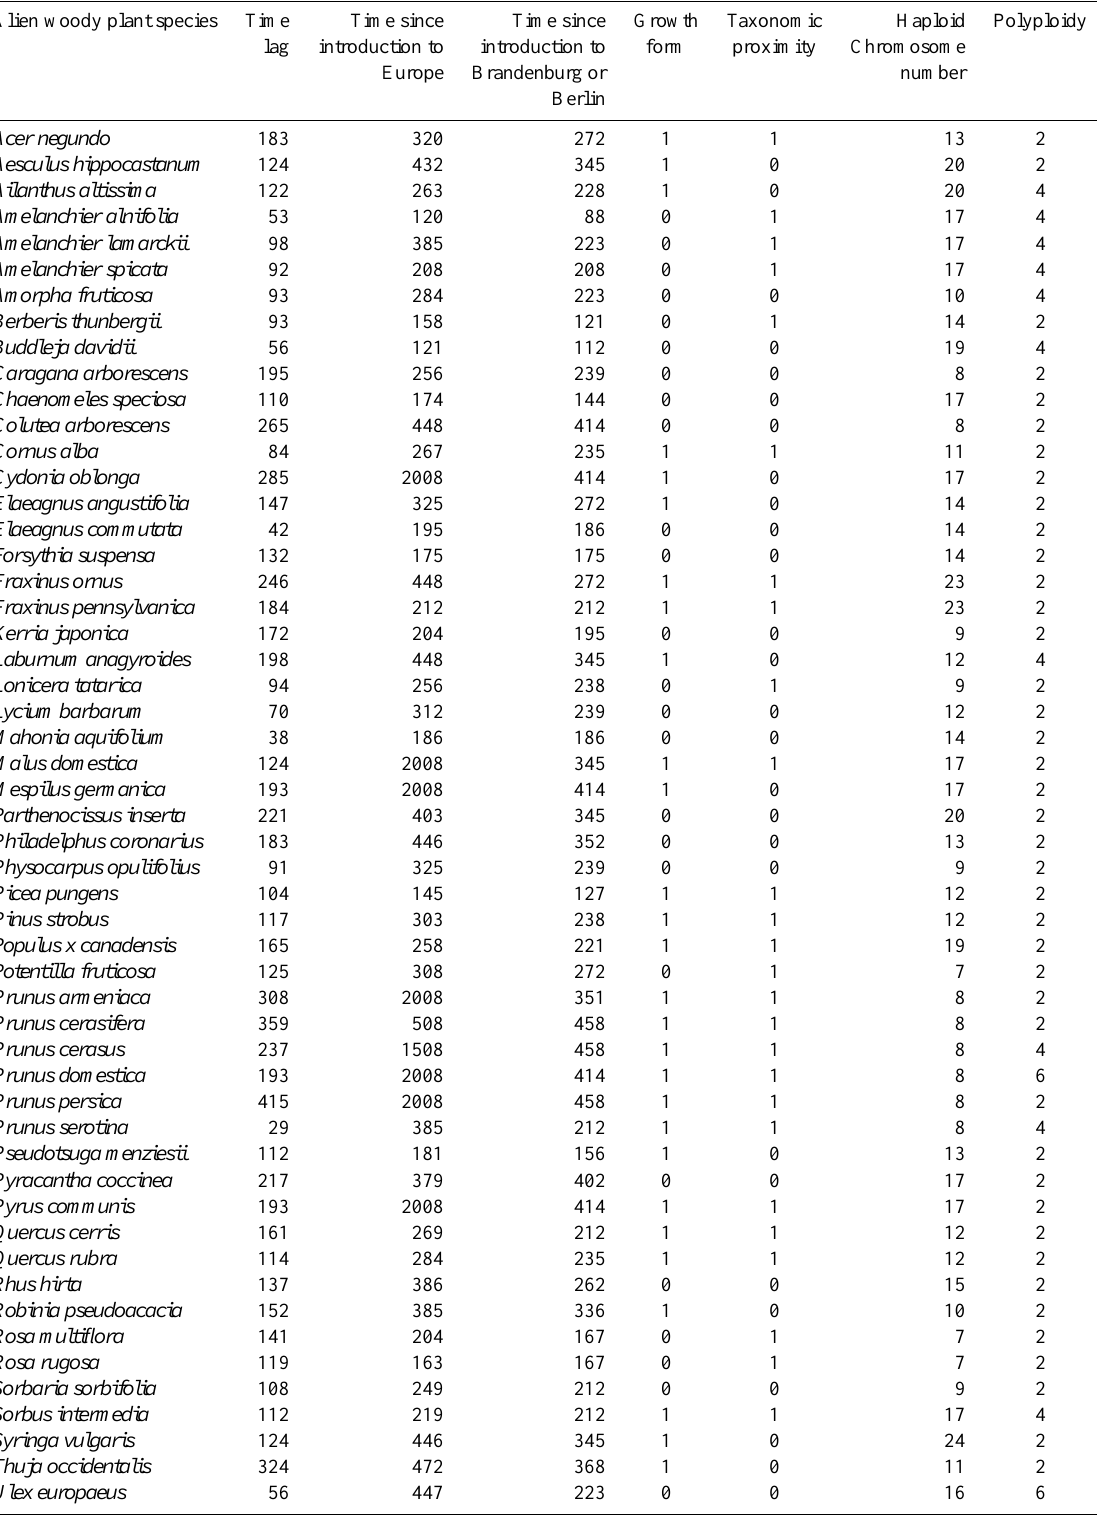
Table 1. Table of the alien woody plant species analysed in the present study. The lag phase (years between introduction and escape from cultivation), time since introduction (years), growth form (0 = shrub or climber, 1 = tree), taxonomic proximity (0 = without native congener, 1 = with native congener) the haploid chromosome number and the level of polyploidy of the species are listed. Alien woody plant